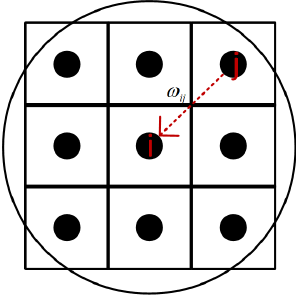
Figure 5. The connection weight w ij from adjacent neuron j to neuron i in the grid